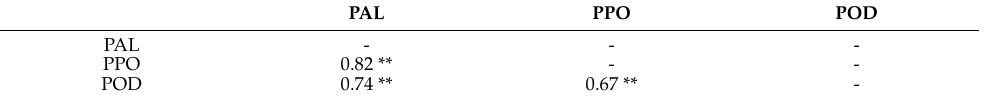
Table 7. Pearson’s correlation coefficients for disease incidence and severity of Fusarium